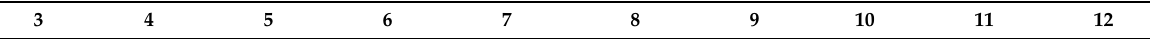
Table 1. Means, standard deviations, and intercorrelations among study variables ( n =